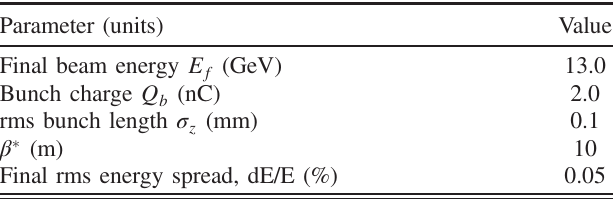
TABLE V. Single-bunch, high-quality mode parameters.